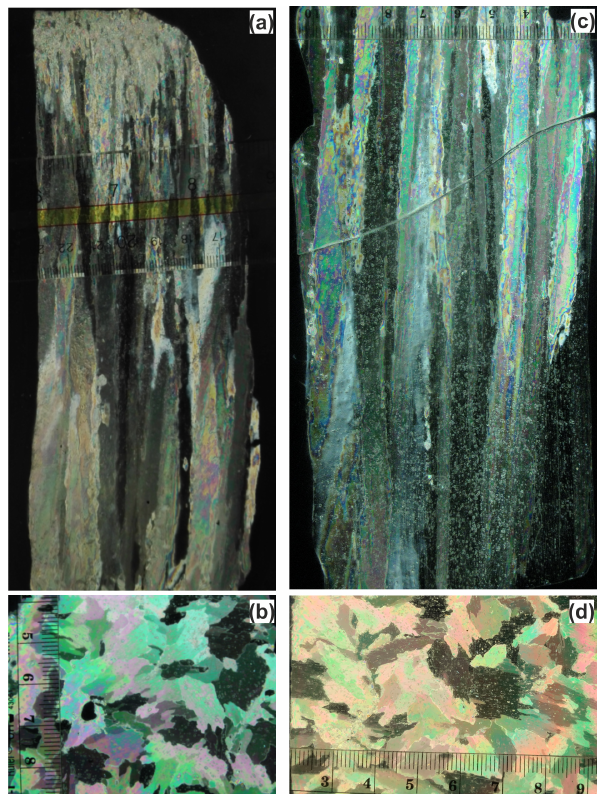
Figure 1. Photographs of a vertically oriented (a) and a horizon- tally oriented (b) thin section ( ∼ 1mm) of columnar-grained, saline ice of lower salinity (3.0 ± 0.9ppt) as viewed between crossed- polarized filters; photographs of a vertically oriented (c) and a hor- izontally oriented (d) thin section of saline ice of higher salinity (5.9 ±